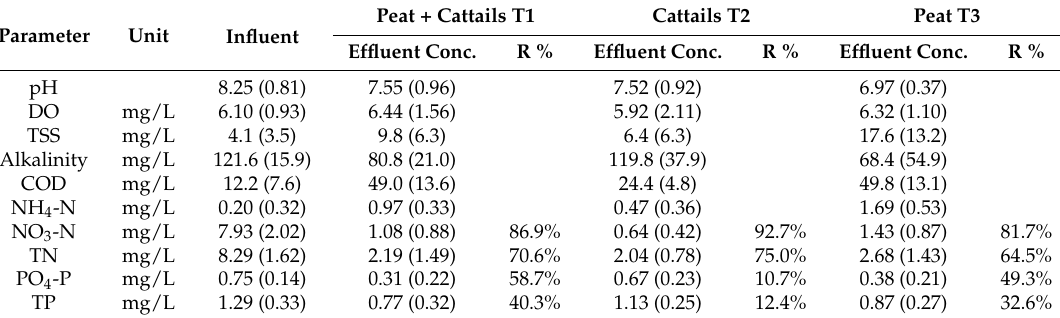
Table 3. Mean effluent pollutant concentrations and removal efficiencies in each treatment wetland reactors for operational period 1